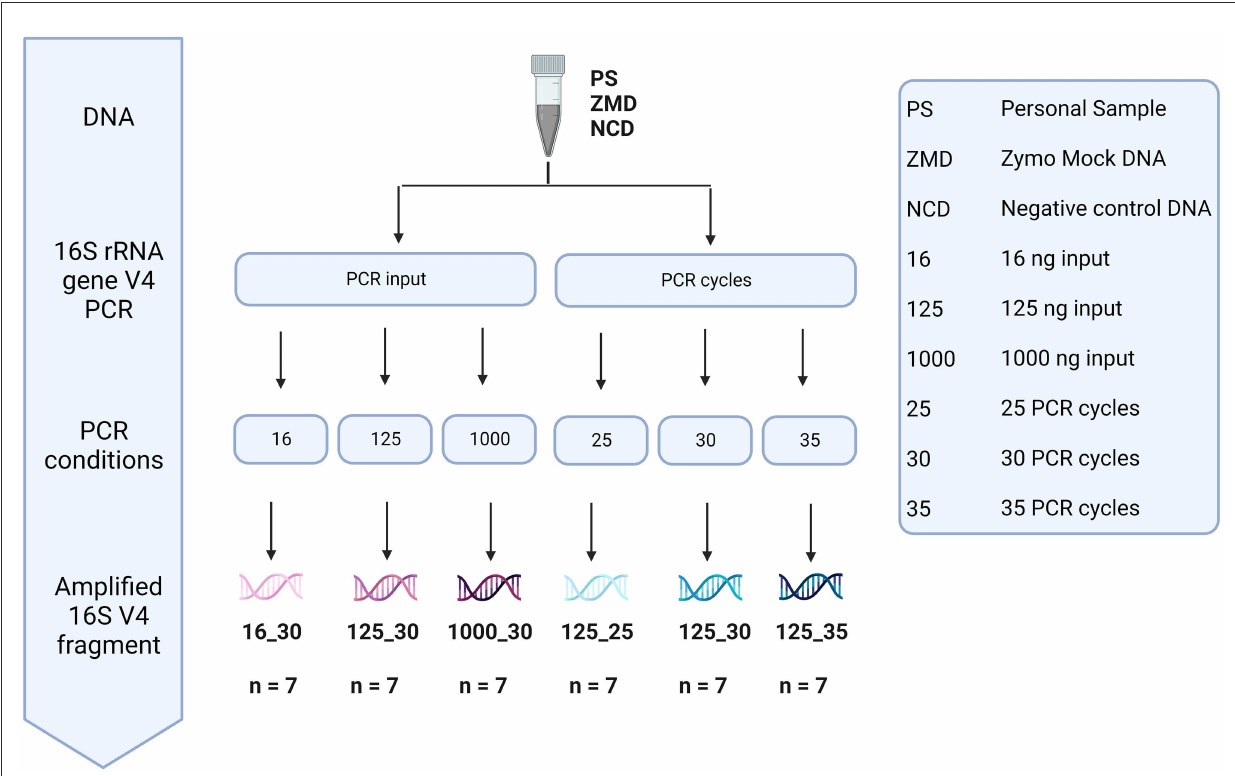
FIGURE9 Overview of the different methods tested during library preparation. The effect of bacterial DNA input (16, 125, and 1,000 pg) and PCR cycles (25, 30, and 35 cycles) was tested using the DNA of three participant samples, three negative controls, and one positive Zymo mock control.